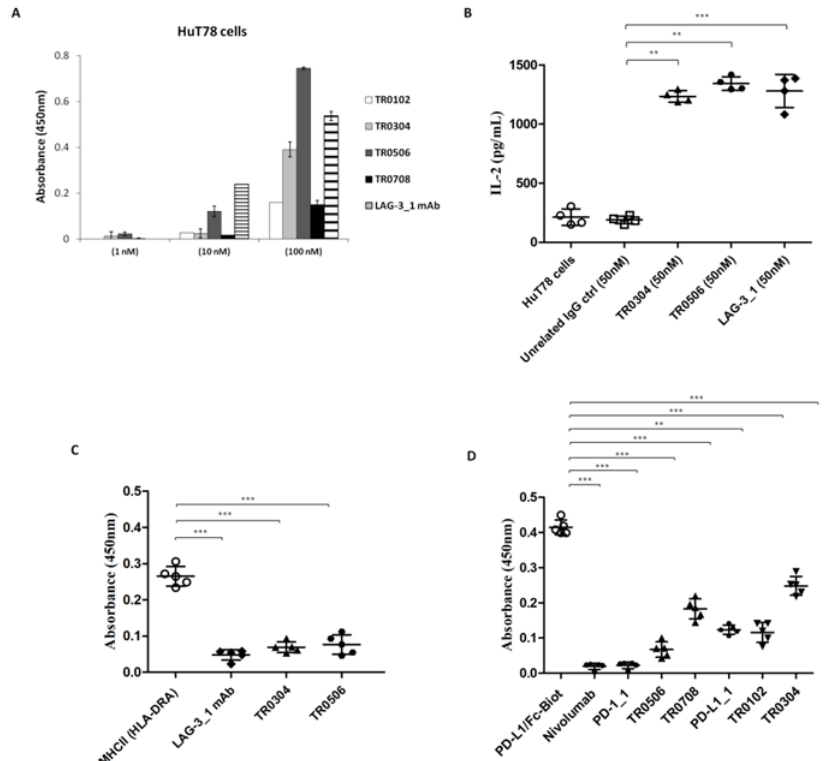
Figure 5. Binding specificity of the TRBs with target ICs and their antagonistic abilities. ( A ) Binding of the immunomodulatory tribodies, or LAG-3_1 parental mAb, tested at increasing concentrations on HuT78 cells by cell ELISA. Error bars depict means ± SD; these were calculated on the basis of results obtained by at least three independent experiments. ( B ) Secretion of IL-2 measured in the supernatants of HuT78 cells, treated as indicated, using a DuoSet ELISA kit. An unrelated antibody was used in parallel as a negative control. ( C , D ) Competitive ELISA to test the interference of the tribodies in LAG-3/MHCII (HLA-DRA) and PD-1/PD-L1 interactions. The binding of biotinylated MHCII or PD-L1 ligand to immobilized LAG-3 or PD-1 receptor, respectively, was measured in the absence or presence of a molar excess of tribodies (3:1 M/M for anti-LAG-3 and 5:1 M/M for anti-PD-L1 mAbs). Error bars depict means ± SD. p -value: *** p ≤ 0.001; ** p <